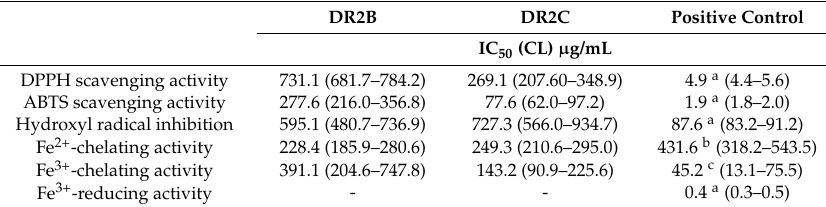
Table 4. IC 50 values of DR2B and DR2C extracts and the positive controls in the antioxidant activity assays. DR2B